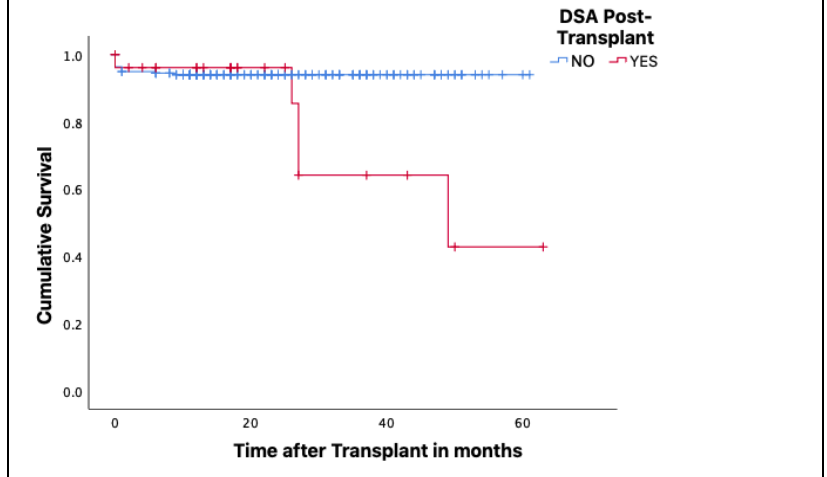
Figure 2. Kaplan – Meier curves to determine renal graft survival, according to the presence or ab- sence of dnDSA. Lower renal graft survival is observed in patients who develop dnDSA.